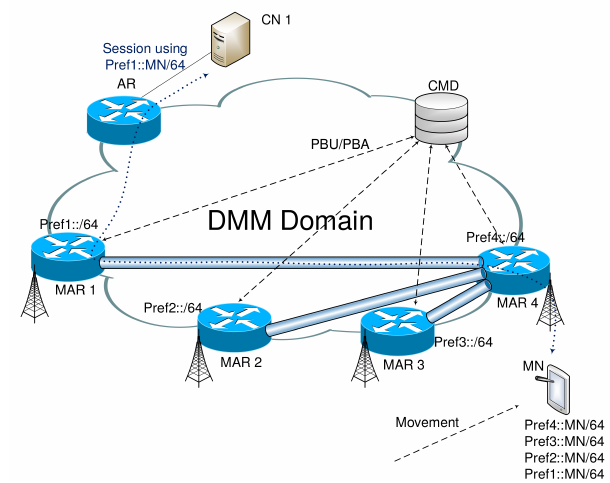
Figure 1. Network-based Distributed Mobility Management (DMM)